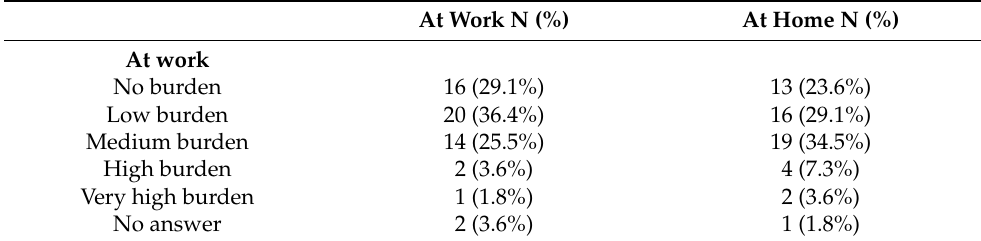
Table 2. Burden because of death and dying (n = 55).